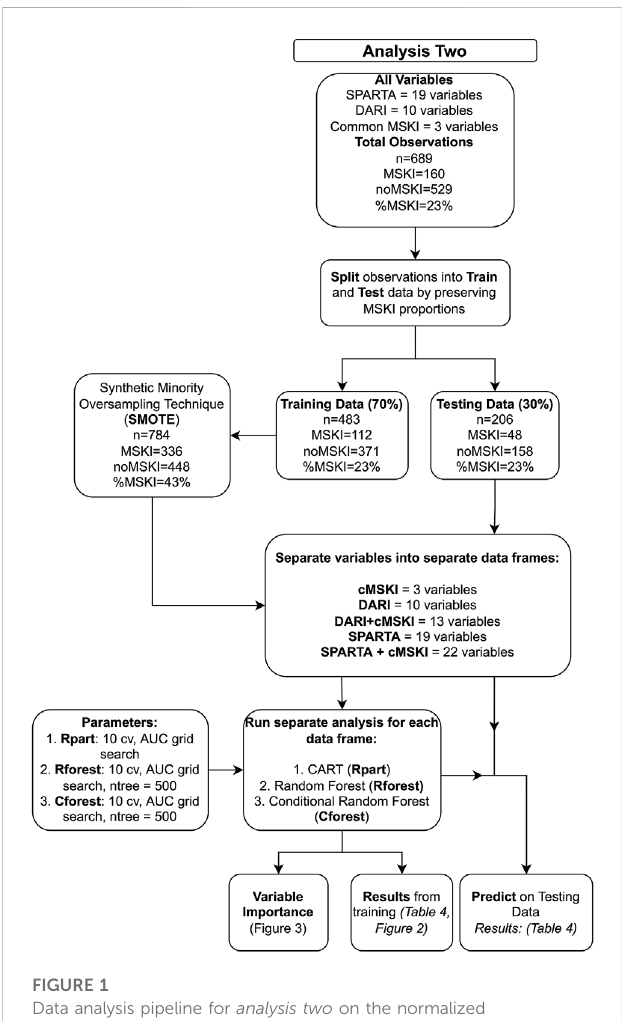
FIGURE 1 Data analysis pipeline for analysis two on the normalized component